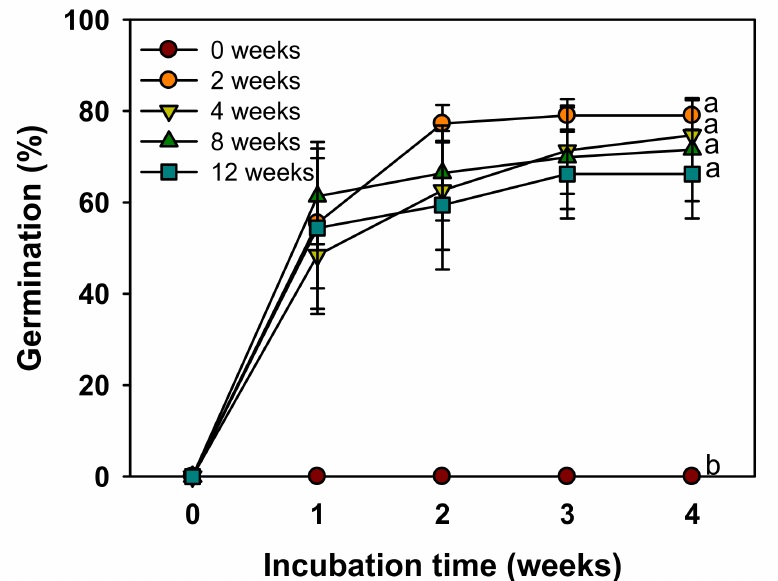
Figure 5. Germination of V. sibiricum seeds as affected by cold stratification periods (0, 2, 4, 8, or 12 weeks at 4 ◦ C). Seeds were incubated at 20/10 ◦ C after the stratification treatment. Error bars indicate mean ± SE of four replicates. The different letters represent statistically significant differences for germination percentages according to treatments in the fourth week as determined by the Tukey’s honestly significant difference (HSD) tests ( p <